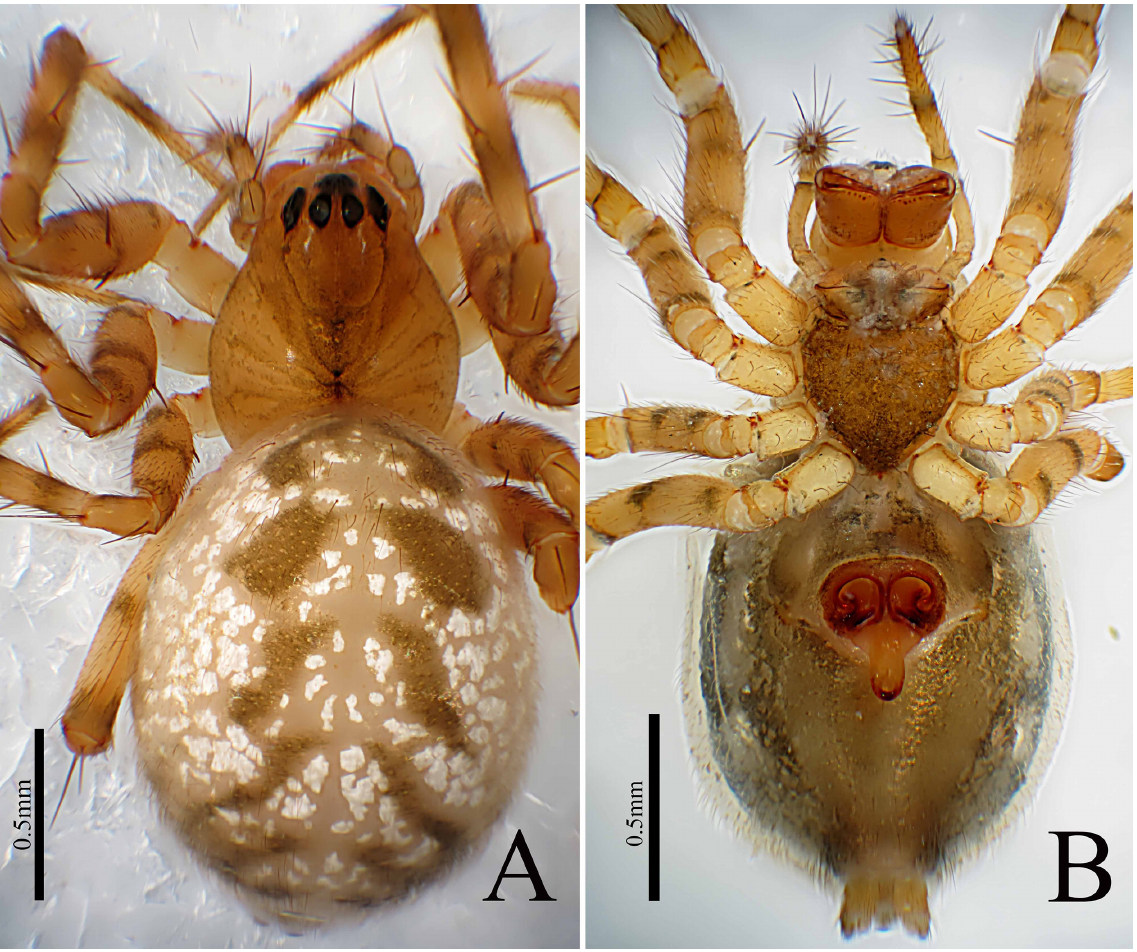
Fig. 23. Acroterius inversus gen. et sp. nov., ♀, holotype (HNU-CGY115). A . Habitus, dorsal view. B . Habitus, ventral